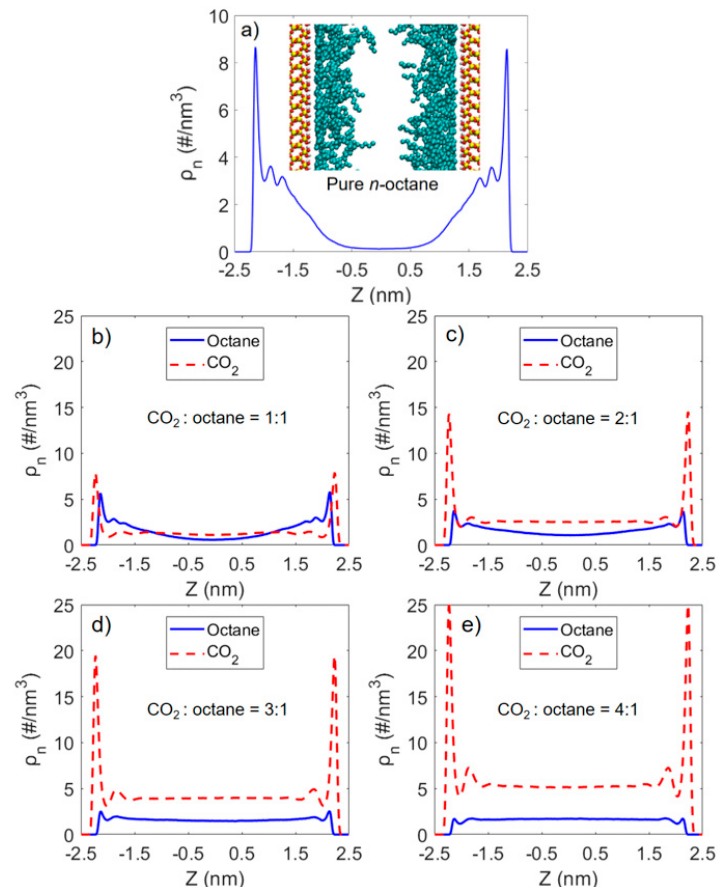
Figure7. Number density profile of CO 2 and n -octane after the addition of different ratio of CO 2 . The mole ratios of CO 2 to n -octane are ( a ) pure n -octane, ( b ) 1:1, ( c ) 2:1, ( d ) 3:1, ( e ) 4:1. The inserted picture is the snapshot of n -octane adsorption after equilibrium. # represents the number of molecules.